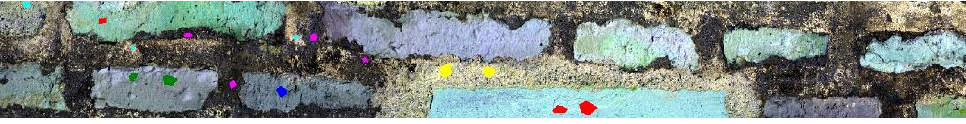
Figure 7. ROI selection of endmembers on the FCIR image.